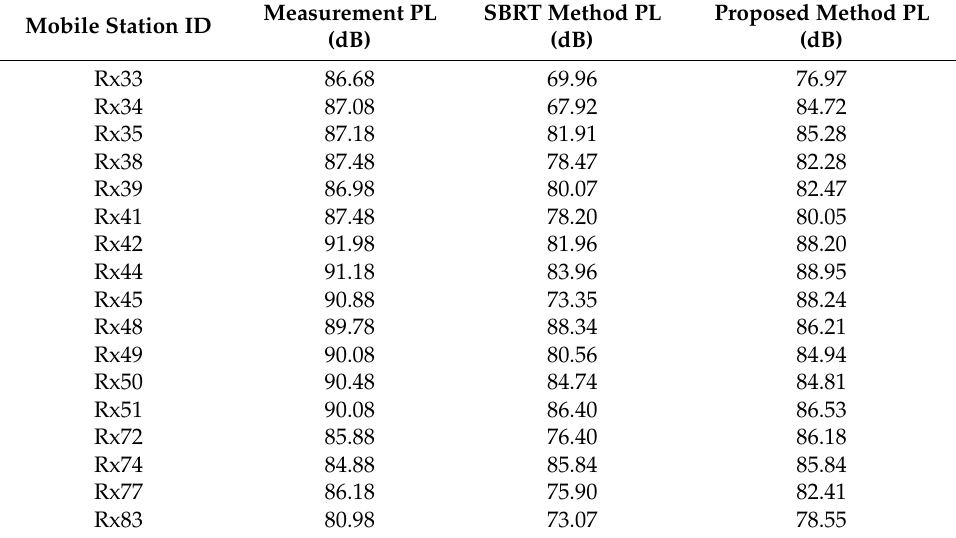
Table 5. The comparison of PL data using measurement, SBRT method, and proposed